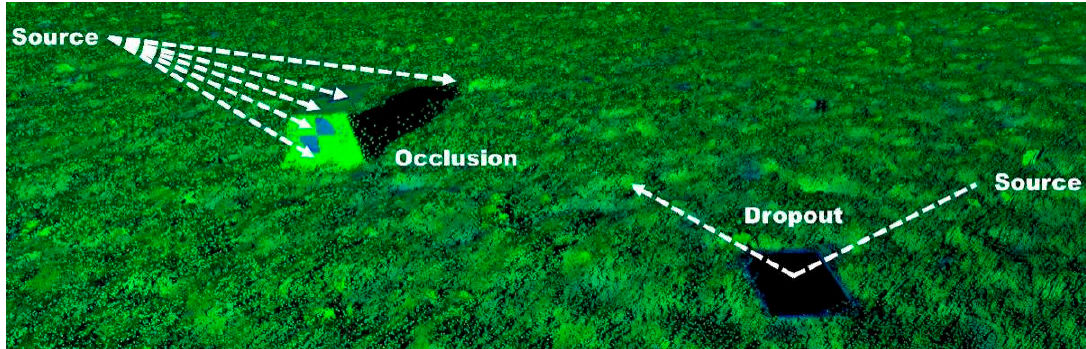
Figure 1. Examples of occlusion and dropout data gaps in terrestrial laser scanning (TLS) data.